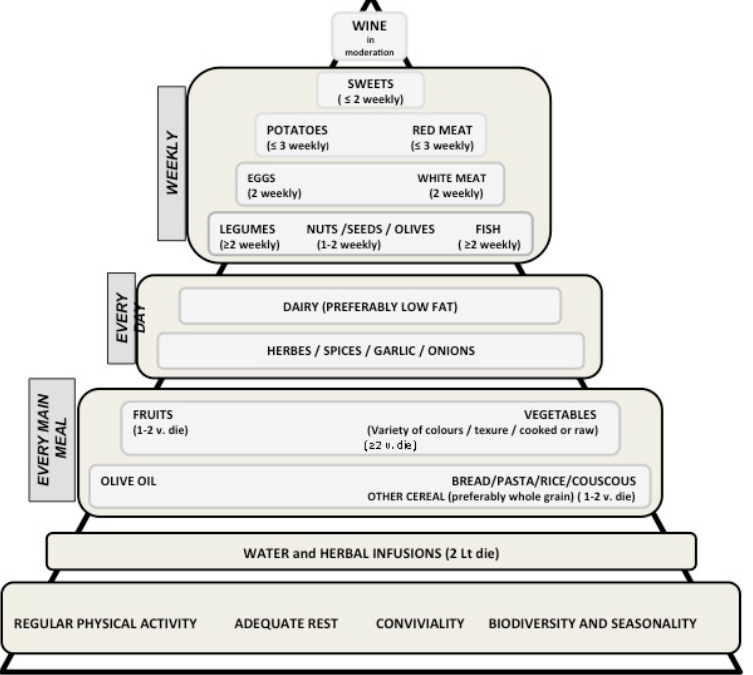
Figure 2. Pyramid of Mediterranean lifestyle (inspired by the “Mediterranean Diet Foundation” Barcelona Spain). The size of different sectors of the pyramid is directly